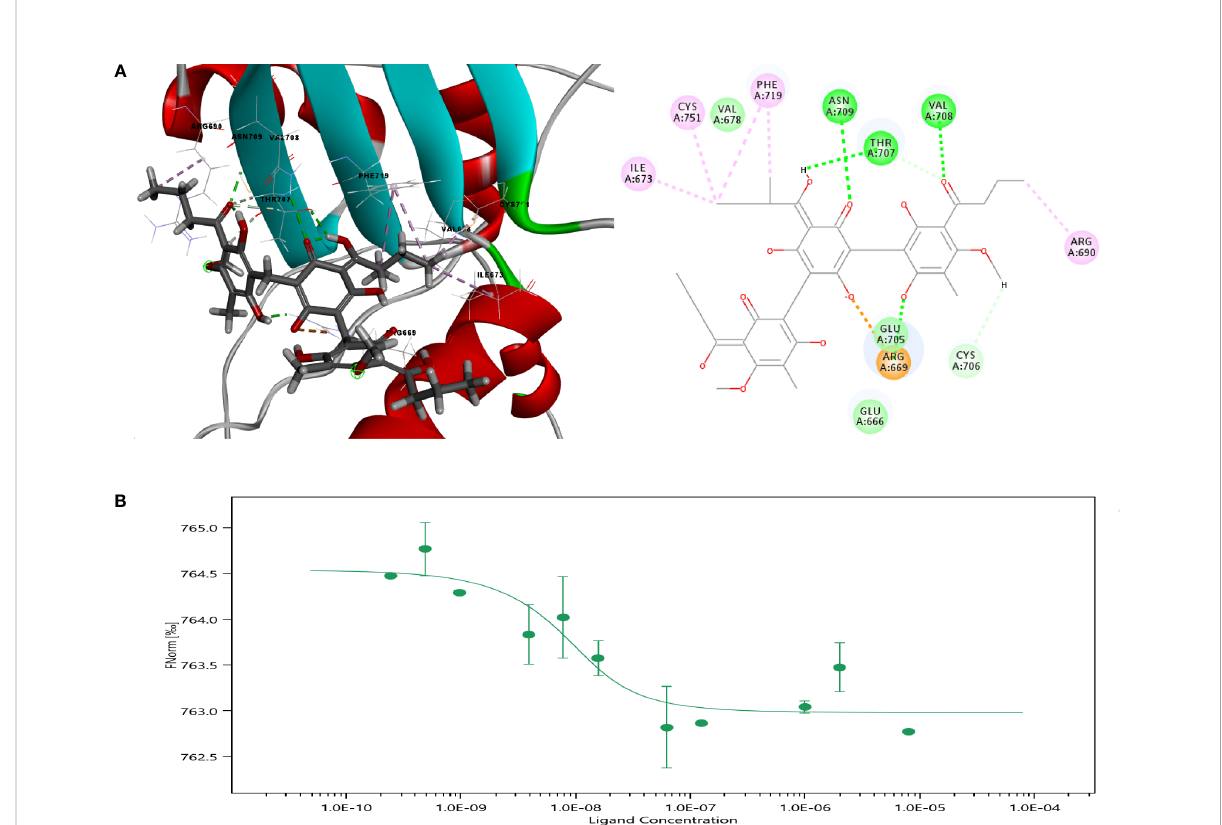
FIGURE 2 Molecular docking of Agr with PGC-1 a . (A) Crystal structure of PGC-1 a and amino acid sites of interactions of Agr with PGC-1 a . (B) Results of microscale thermophoresis for Agr versus PGC-1 a . Agr, agrimol B; PGC-1 a , peroxisome proliferator-activated receptor- g coactivator 1 a